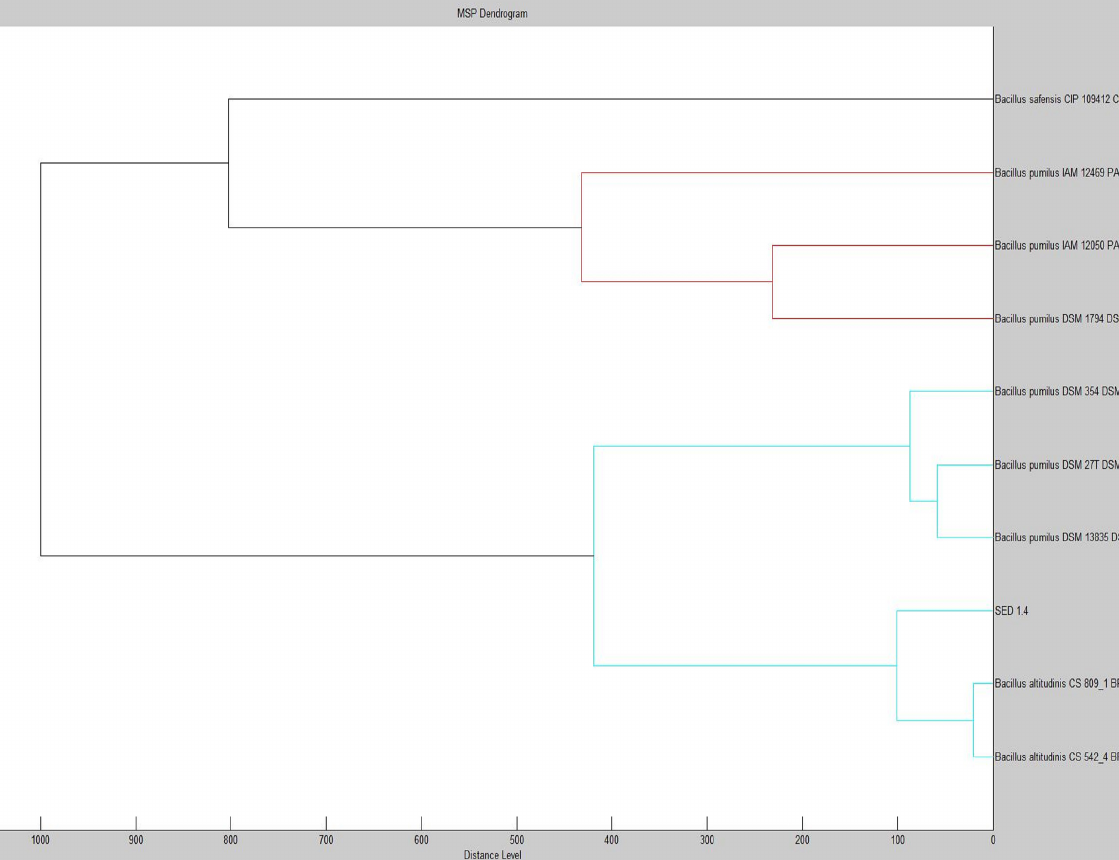
Figure 2. Phylogenetic tree obtained from the 16S rRNA gene of the sequences with closer similarities suggested by BLAST and identified isolates from other studied